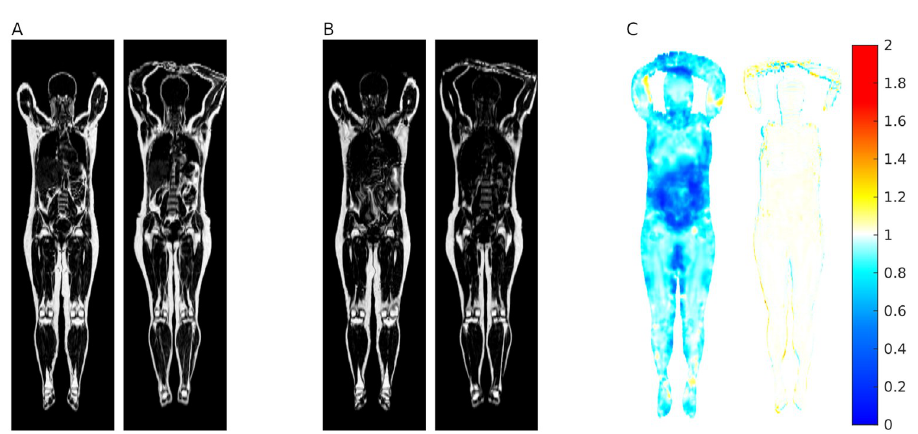
Fig 6. Comparison between the reference spaces generated by out method and Elastix. A: Slice of the resulting registered fat image of a subject, for Elastix (left), and our method (right). In this case, some artefacts are observable in the result from Elastix (e.g. in the subcutaneous fat), but overall the result of the registration appears to be reasonable for both methods. B: results for another subject, for Elastix (left) and our method (right). This subject is more challenging to register, and in the output from Elastix it is possible to notice visible artefacts, such as the spine being out of place, and visible distortion of the internal organs and the subcutaneous fat between the thighs. By comparison, our method does not introduce artefacts of this type. C: Average Jacobian determinant for Elastix (left) and our method (right).